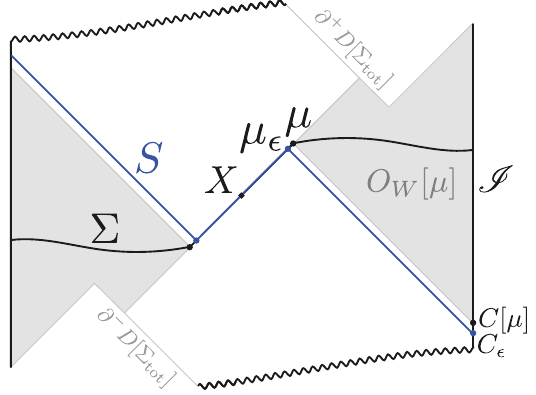
Figure 12 . Construction of Cauchy surface S on which X is minimal in the globally hyperbolic region of the coarse grained spacetime D [Σ]